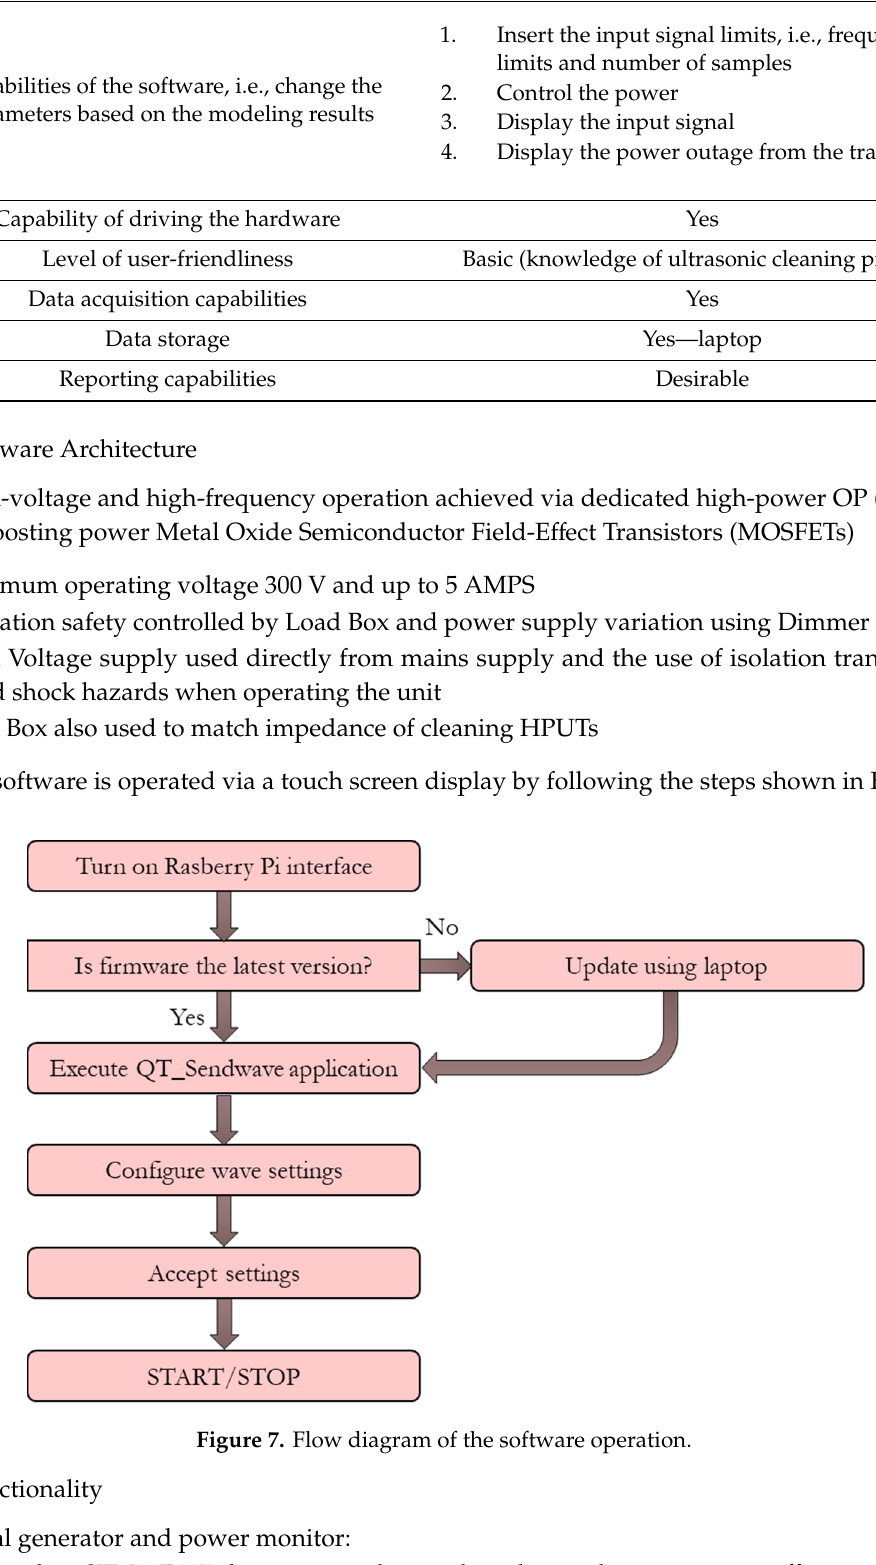
Table 5. Power ultrasonic software requirements.